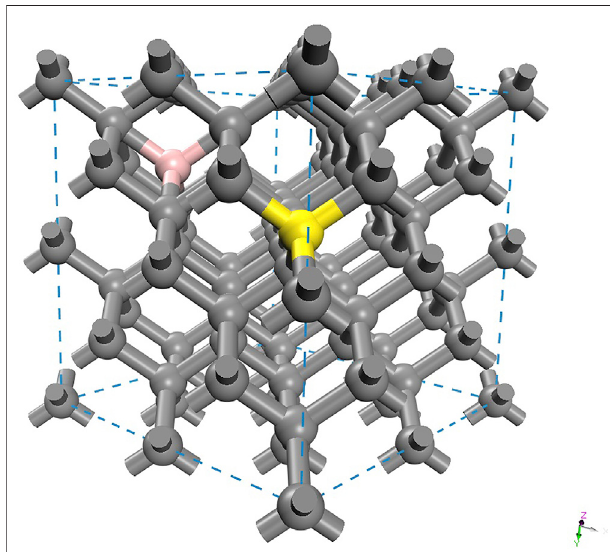
FIGURE 1 | Simulation cell of diamond (dark gray) showing interstitial (pink) and substitutional (golden) positions.